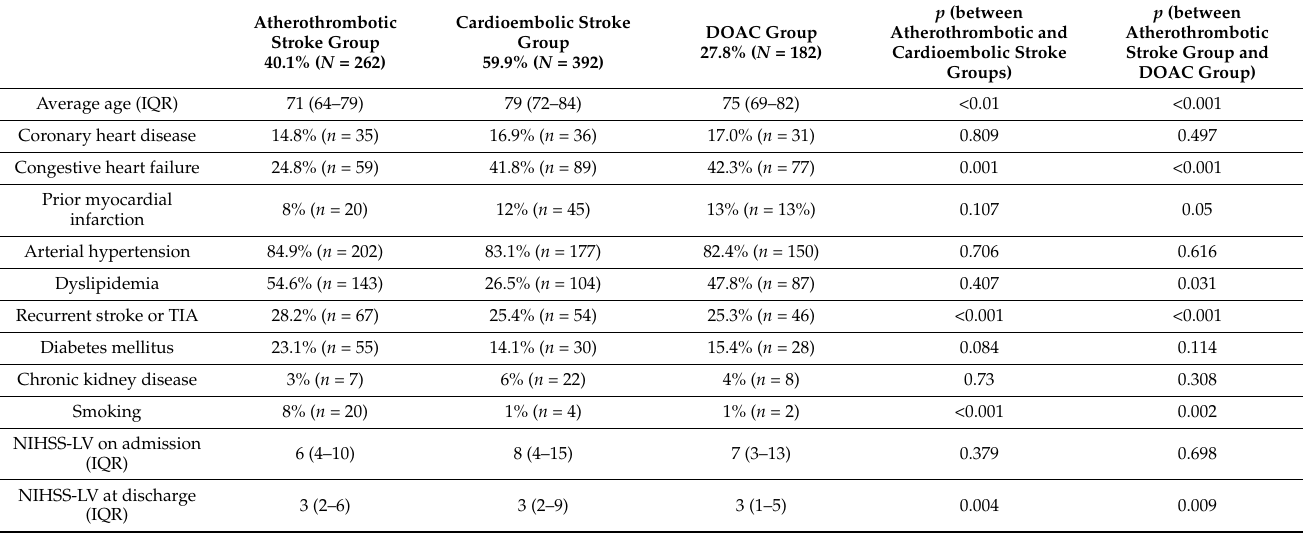
Table 2. The patients’ demographic characteristics and neurological